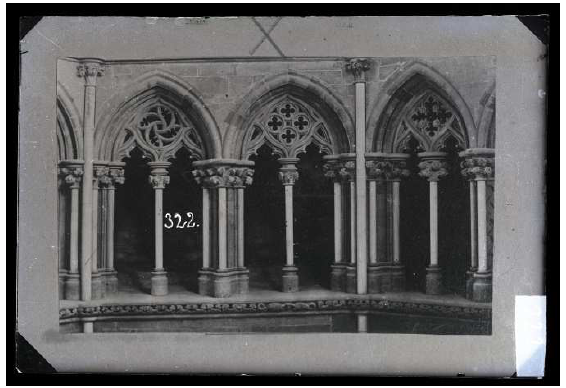
Figure 7. Condition of the North-East bay and half of the East bay after the restoration (NDR Archive: Nr.